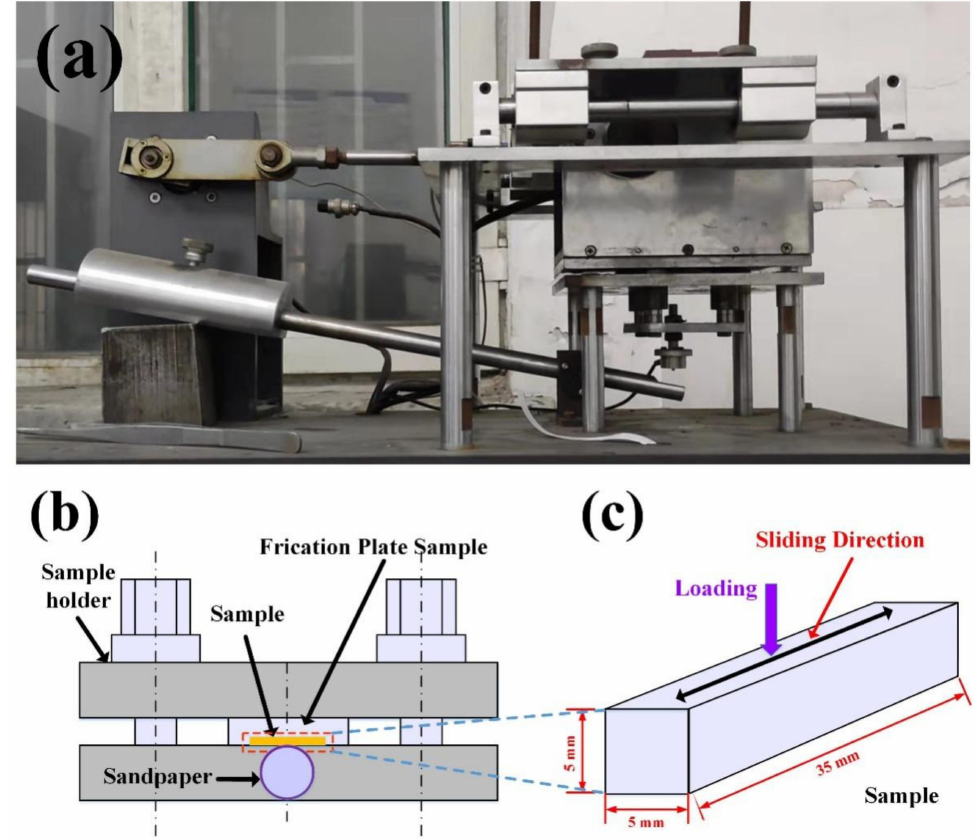
Figure 2. Schematic diagram of abrasive wear process: ( a ) machine, ( b ) sample stage, ( c ) wear direction and sample